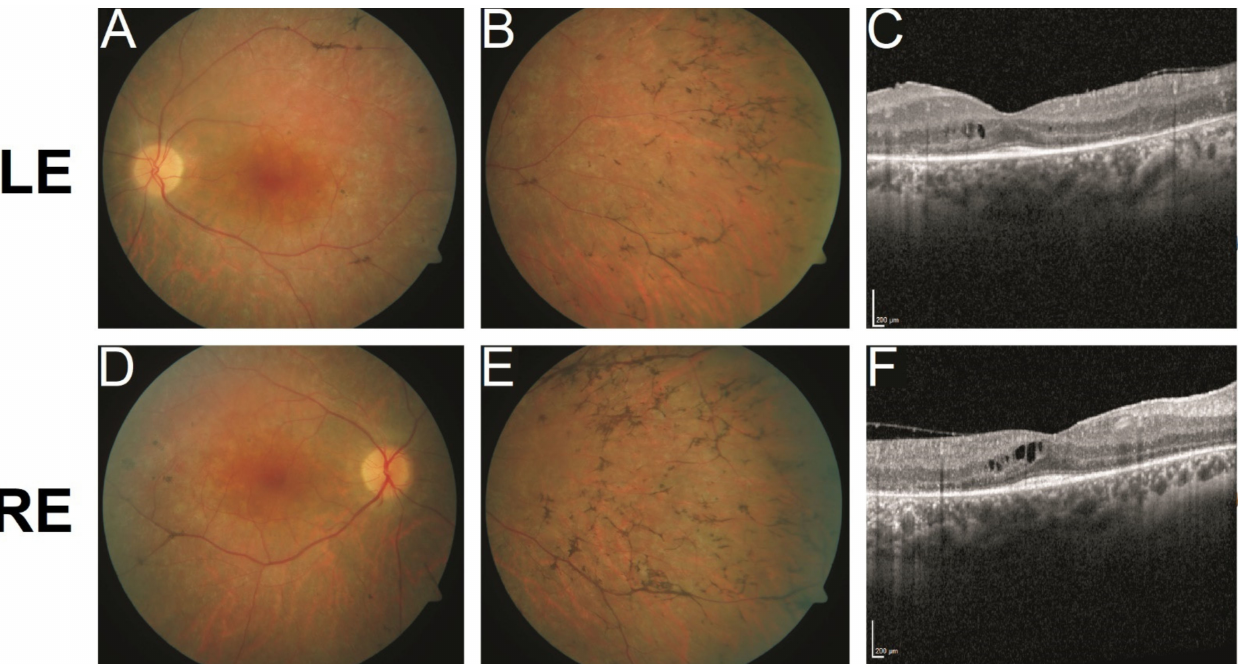
Figure 2. Central retinal fundus photography of ( A ) left eye (LE); and ( D ) right eye (RE). Mid- peripheral view of the fundus of ( B ) LE; and ( E ) RE. Vessel attenuation, atrophy of the retinal pigment epithelium and bone-spicule changes are evident in the fundus pictures, all typical for retinitis pigmentosa. Optical coherence tomography (OCT) of ( C ) LE; and ( F ) RE. Scale bars = 200 µ m. Visualization of retinal layers with OCT shows reduced photoreceptor outer segments up to the fovea. Note several cystic spaces in the inner nuclear layer as a sign of macula edema, a common complication in retinitis